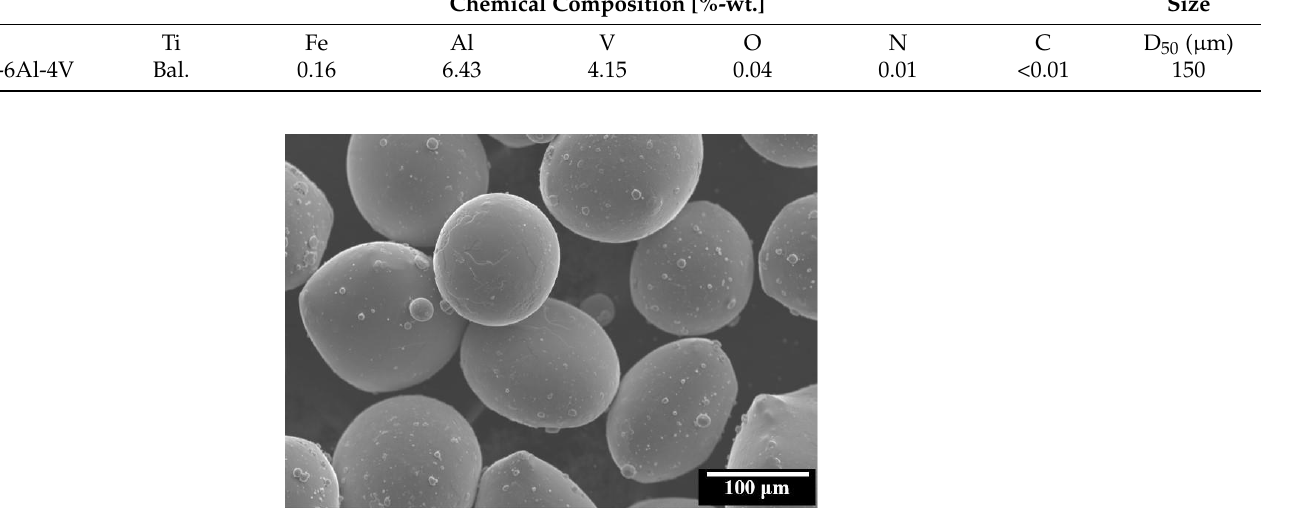
Table 1. Chemical composition and average size of the base powder. Chemical Composition [%-wt.]